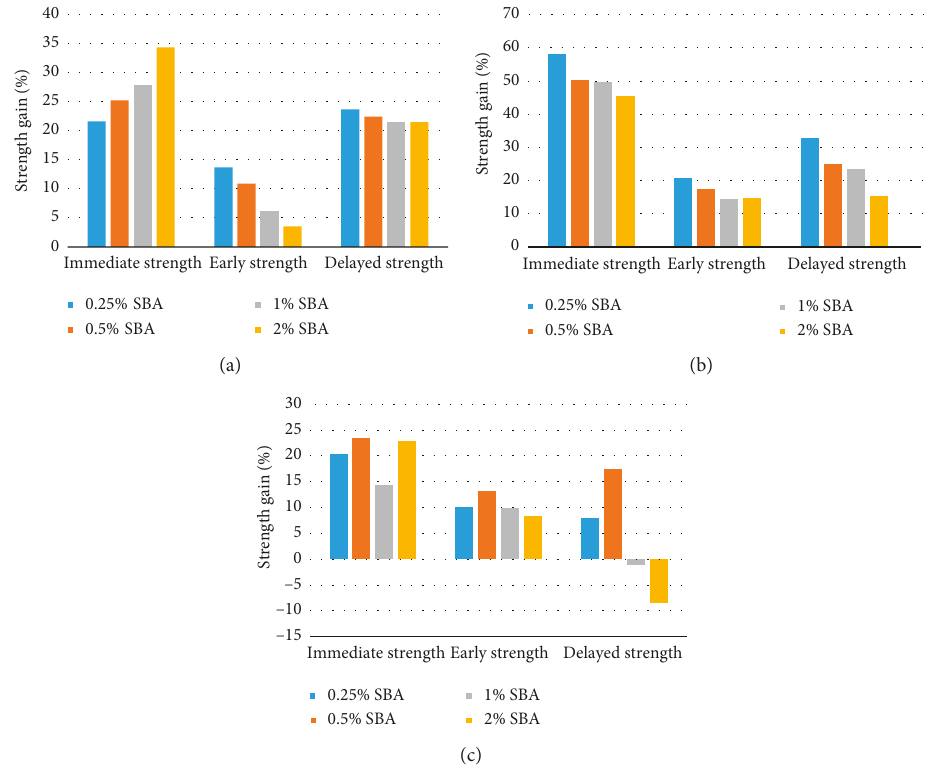
Figure 7: Percentage strength gain of (a) 3%, (b) 5.5%, and (c) 7% lime stabilized soil with